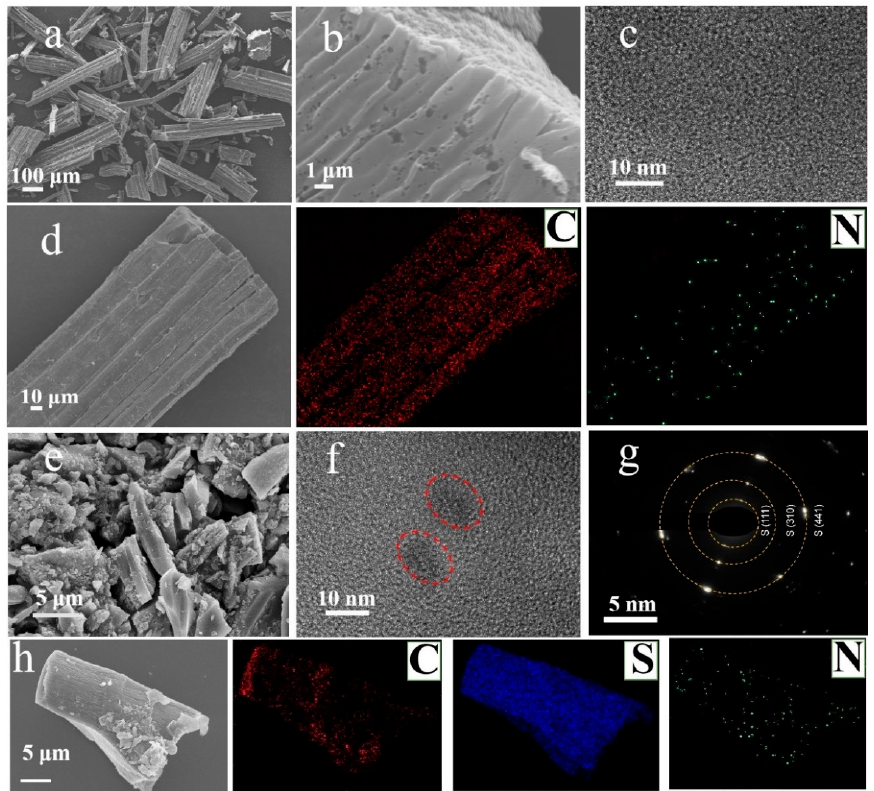
clearly seen (Figure 3h).